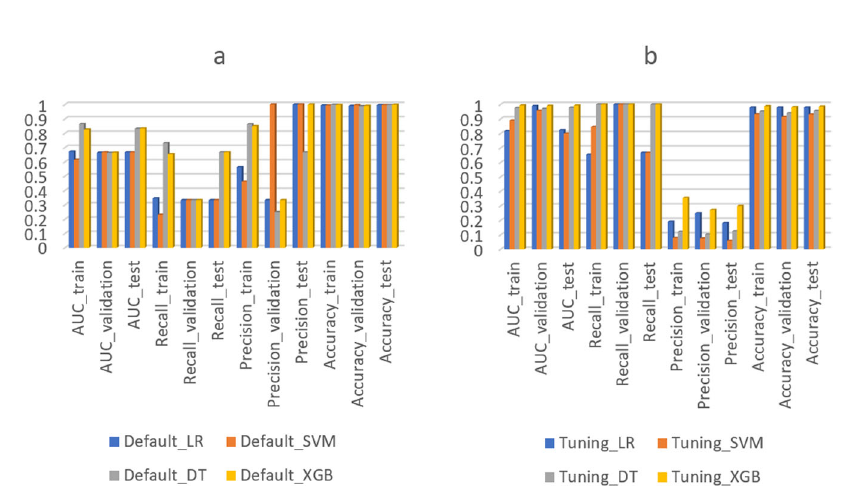
Fig. 1 Model performance for four different algorithms (including Extreme gradient boosting (XGB), Decision tree (DT), Logistic regression (LR), and Support vector machine (SVM)), with default parameter settings (a) and with tuned parameter settings